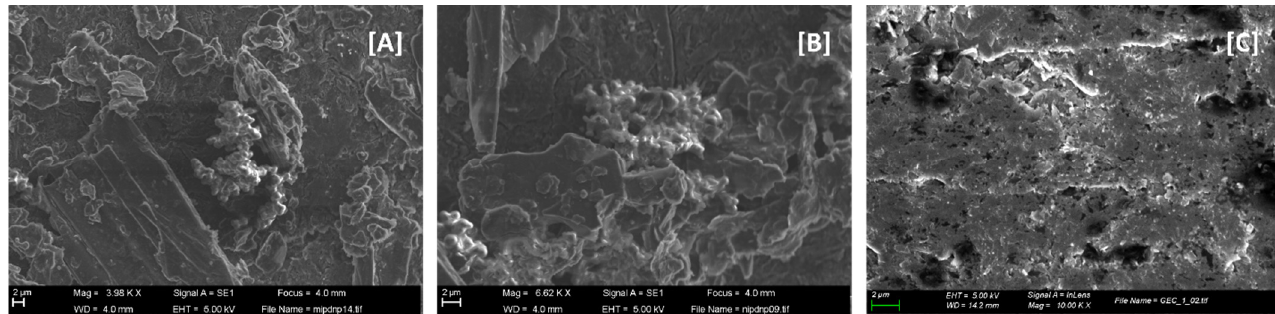
Figure 3. Scanning electron microscopy (SEM) images with secondary electron detector for the MIP-sensor ( A ) and NIP-sensor ( B ) and GEC electrode ( C ).